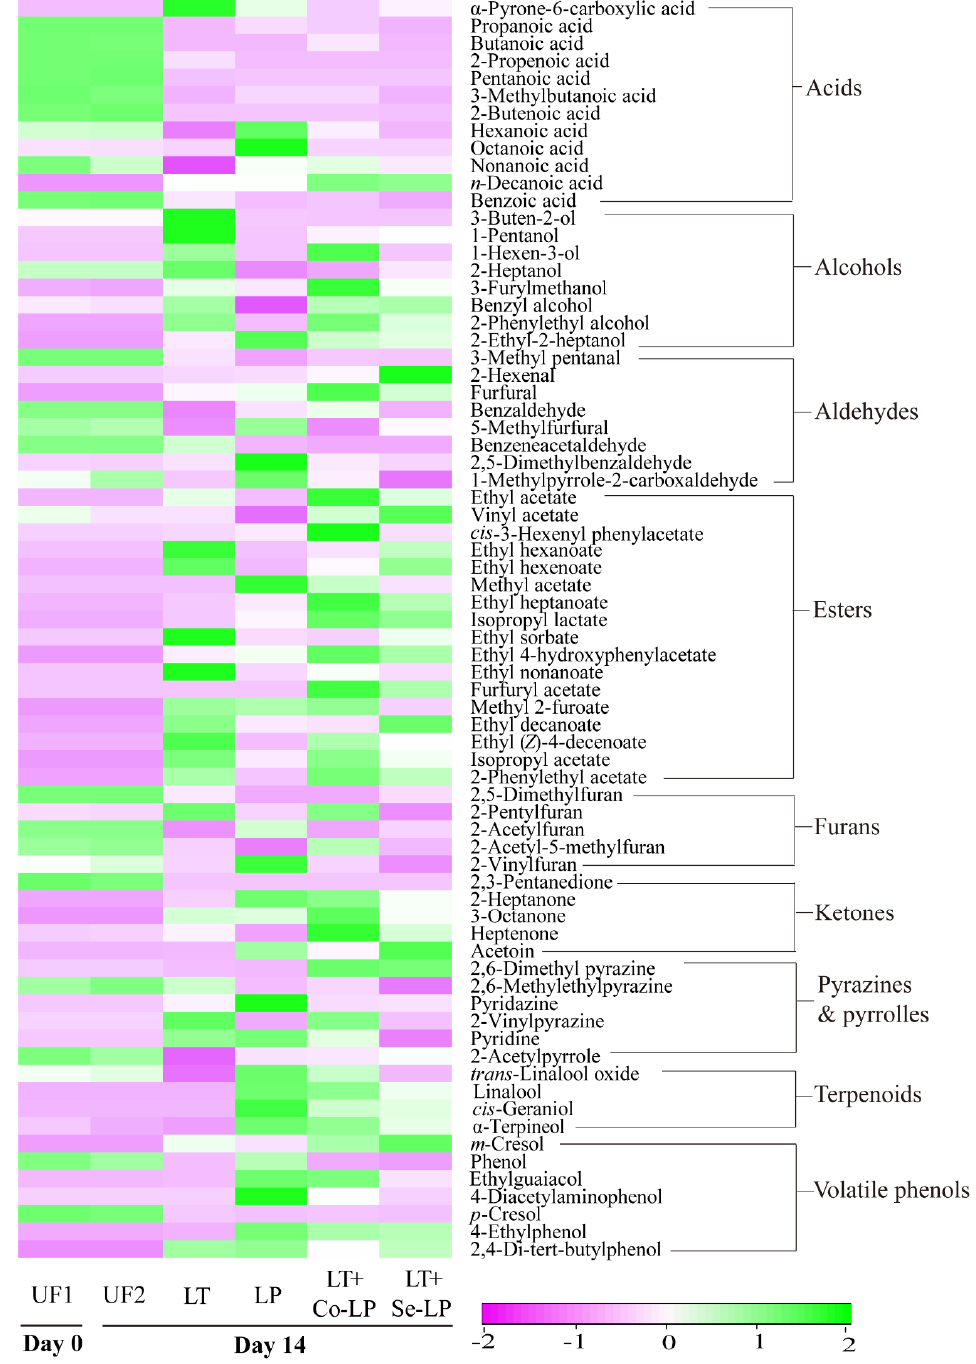
Figure 6. Heatmap of volatile profiles of SCG hydrolysates fermented with L. thermotolerans Concerto and L. plantarum ML Prime. UF1 and UF2: Unfermented SCG hydrolysates at D0 and D14; LT: L. thermotolerans Concerto; LP: L. plantarum ML Prime; LT+Co-LP: simultaneous inoculation of L. thermotolerans Concerto and L. plantarum ML Prime; LT+Se-LP: L. thermotolerans Concerto with sequentially inoculated L. plantarum ML Prime at day